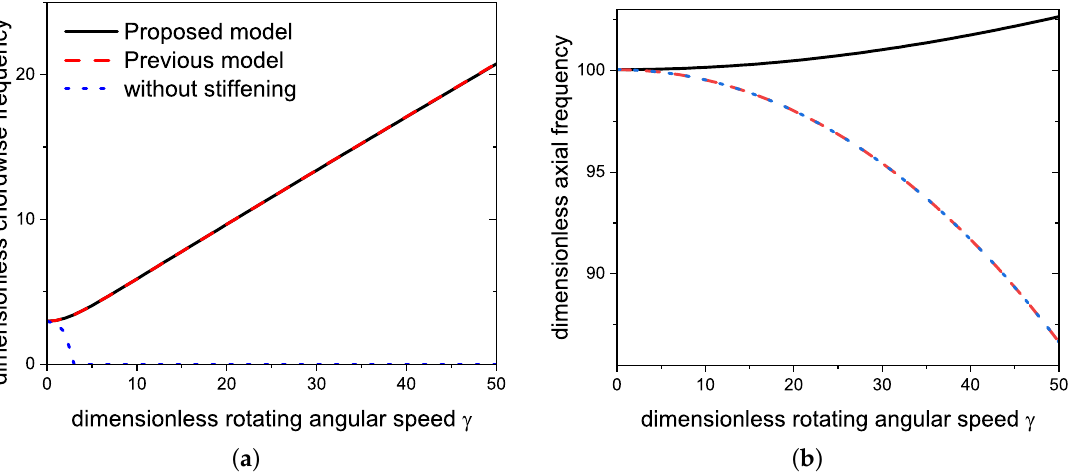
Figure 6. The first-order dimensionless frequency of rotating cantilever beams with free end mass: ( a ) Chordwise frequency; ( b ) Axial